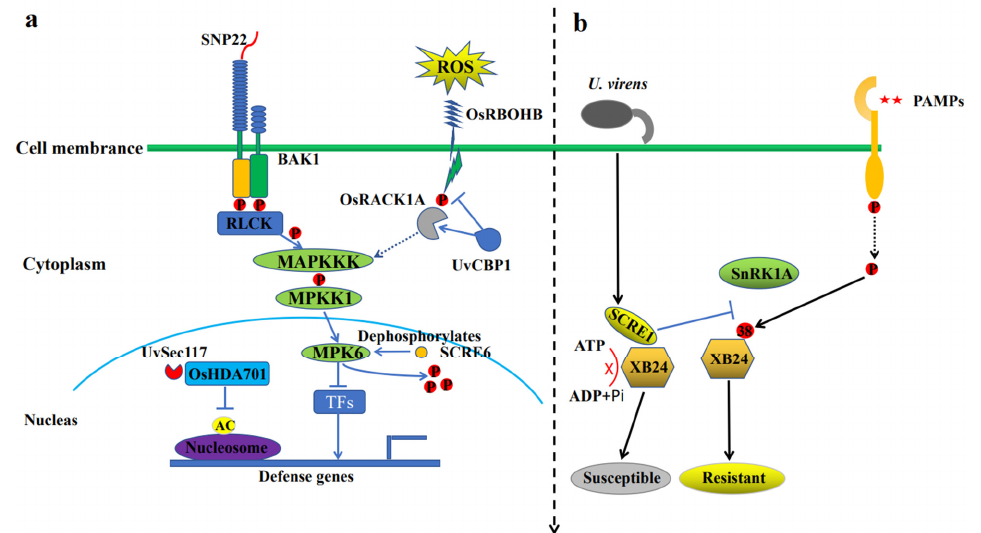
Figure 2. Model of the PAMP triggering the host immune response. ( a ) (I) Pattern recognition re- ceptors (PRR) composed of some leucine-rich repeating (LRR-RLK) protein kinases and brassinosteroid receptor-associated kinase 1 (BAK1) in rice can detect the effector protein SNP22 in rice, thereby activating the downstream defence response; (II) after transfer, the phosphatase effector SCRE6 of Aspergilus oryzae interacts with the mitogen-activated protein kinase 6 (OsMPK6) to dephosphorylate OsMPK6 and enhance its stability, thus negatively regulating the rice immune response; (III) the toxic protein UvSec117 interacts with OsHDA701 and recruits a large amount of OsHDA701 to the nucleus, thereby enhancing the deacetylation activity of OsHDA701 and inhibiting chromosomal opening, which inhibits the binding of transcription-related proteins, thus interfering with the acti- vation of defence genes and host immune response; and (IV) the effecting factor UvCBP1 interacts with the rice scaffold protein OsRACK1A and competes for its interaction with NADPH oxidase OsRBOHB, leading to the production of reactive oxygen species (ROS), which interferes with the defence host immune response. ( b ) The energy regulatory protein SnRK1A in rice interacts with XB24 and phosphorylates its amino acid Thr83 to increase the activity of its ATPase, activating the rice immune signalling pathway and showing resistance to disease. However, SCRE1, an effector secreted by SMF, specifically interacts with XB24 in rice, blocking the binding of XB24 to ATP. At the same time, SCRE1 competitively inhibits the interaction between SnKR1A and XB24, thereby inhibiting the phosphorylation cascade of SnRK1A-XB24 and the activity of ATPase, thus inhibiting the immune response of rice and showing susceptibility to the